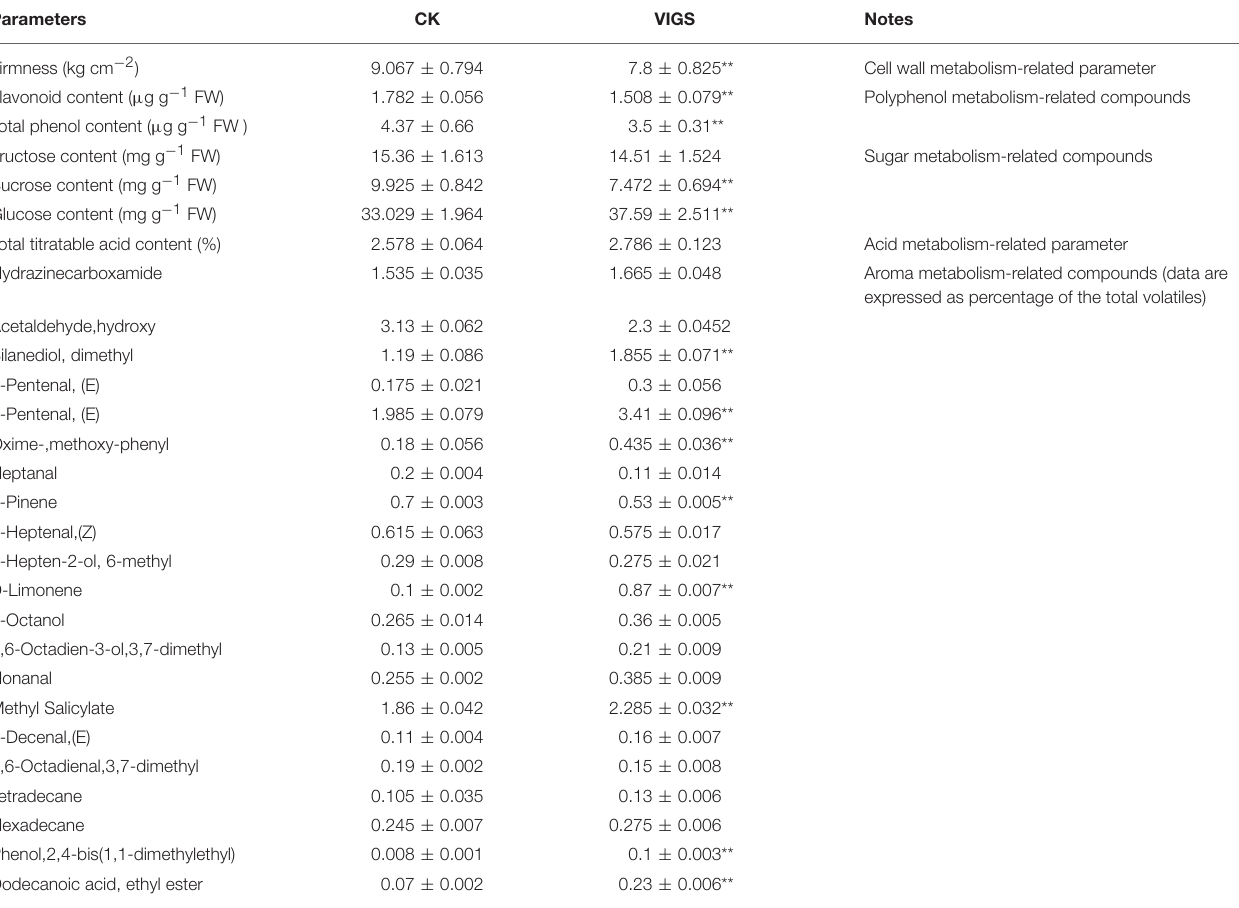
TABLE 1 | Effects of SlFERL1 -VIGS (virus-induced gene silencing) on major fruit ripening-related parameters.